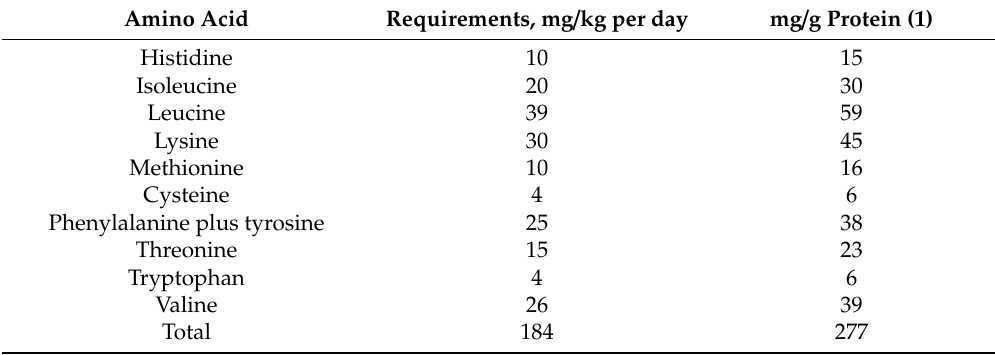
Table 3. Recommendation of estimated amino-acids requirement From WHO (2007) [87]. Amino Acid Requirements, mg / kg per day mg / g Protein